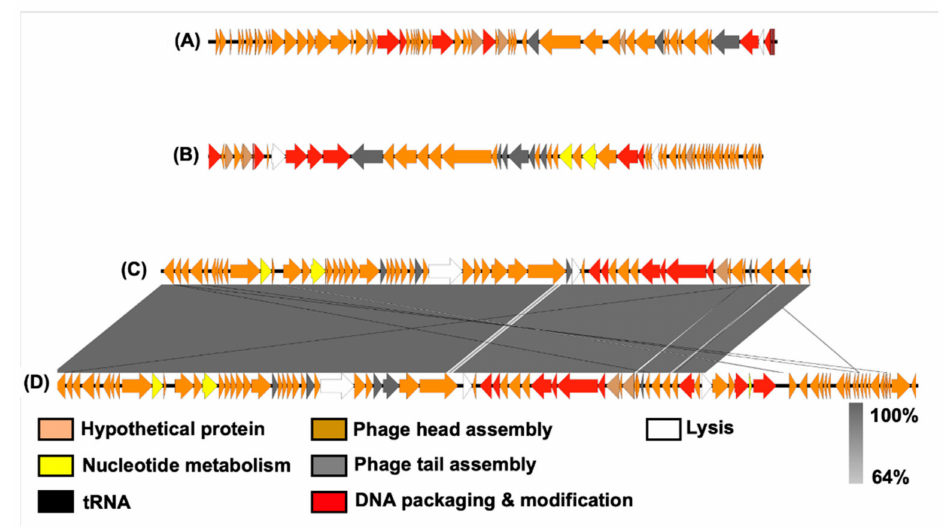
Figure 7. Diagram showing the alignment and genomic synteny comparison between the four phages: ( A ) Pseudomonas Phage_AUS034, ( B ) Pseudomonas Phage_AUS260, ( C ) Pseudomonas Phage_AUS301 and ( D ) Pseudomonas Phage_AUS391. The coding sequences identified are repre- sented by the arrows.